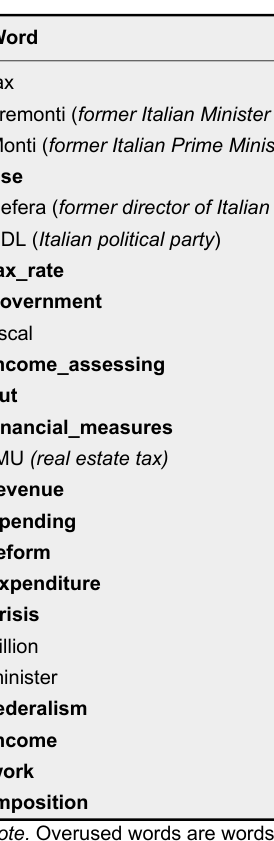
Specificity Analysis: Overused Words in Italy Between 2010 and